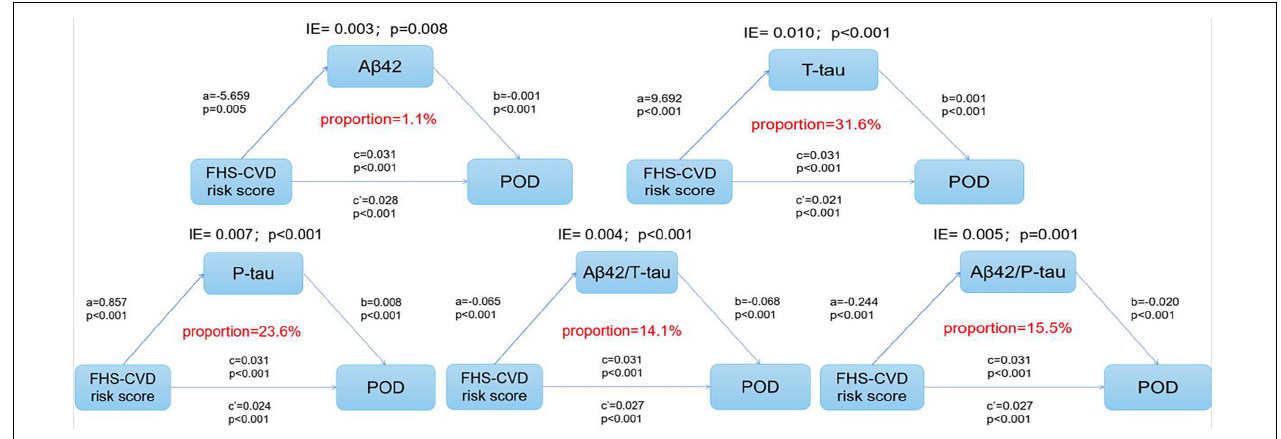
FIGURE 4 | The mediation analysis showed that the relationship between FHS–CVD risk score and POD was mediated by T-tau and P-tau protein.